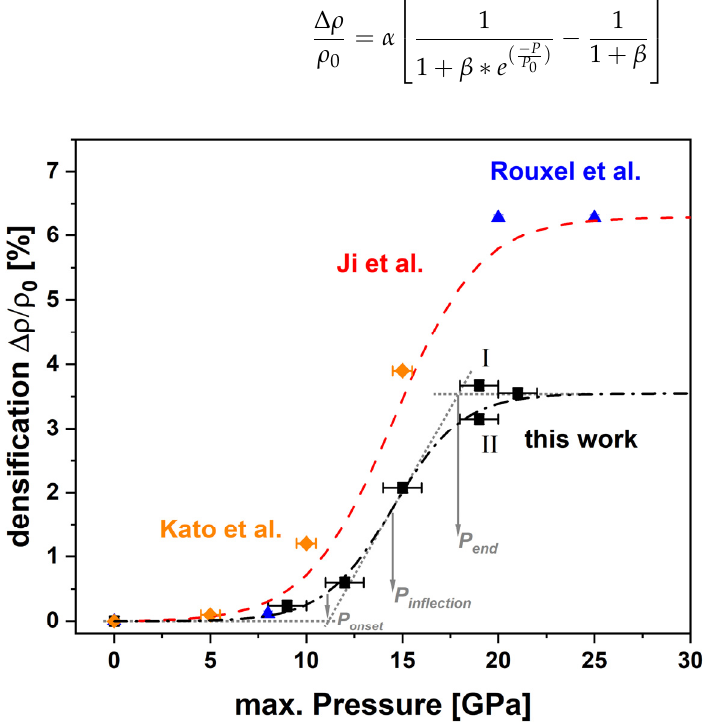
Figure 7. Percentage of densification [%] ( ρ pristine glass = 2.505 g/cm 3 /±0.002 g/cm 3 ) over increasing maximum pressure (0, 9, 12, 15, 19 I, 19 II, 21 GPa/±1.0 GPa) of hydrostatic compressed soda–lime–silicate glass; gray dashed lines and arrows indicate the location of P onset , P inflection and P end ; black data ≙ this study and its corresponding sigmoidal fitting (Equation (5)); the linear approach is giving a P onset = 10.9 ± 0.8 GPa, P end = 18.1 ± 0.8 GPa and P inflection = 14.5 ± 0.3 GPa with m = 0.14 ± 0.02; the maximal variation ∆ was determined at 3.55 ± 0.14%; studies by Rouxel et al. (blue) and Ji et al. (red dashed line) report an earlier P onset = 10.1 GPa and a significant higher saturation at 6.3% after P end = 19 GPa; P inflection is determined at the same value of 14.5 GPa with a slightly lower slope m = 0.11; studies by Kato et al. Table 1. Sigmoidal fitting parameters (Equation (5)) for densification and various spectroscopic methods in relation to the centroid σ versus P max .